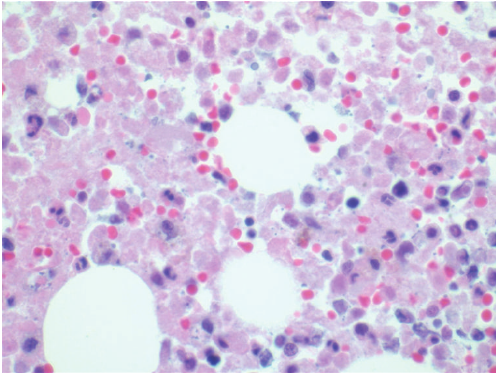
Figure 1: Photomicrograph of the preinduction chemotherapy of bone marrow showing di ff use infiltration by malignant cells.